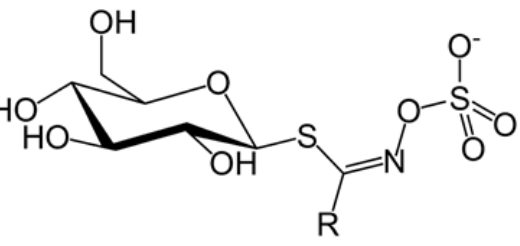
the glucose molecule and the hydroxysulfate ion are detached from the structure. As a result, a biologically active compound called benzyl isothiocyanate is formed, which is the major intermediate to benzylamine formation [29]. An understanding of the mechanisms of glucosinolates transformation is essential to determine their presence in plant extracts.